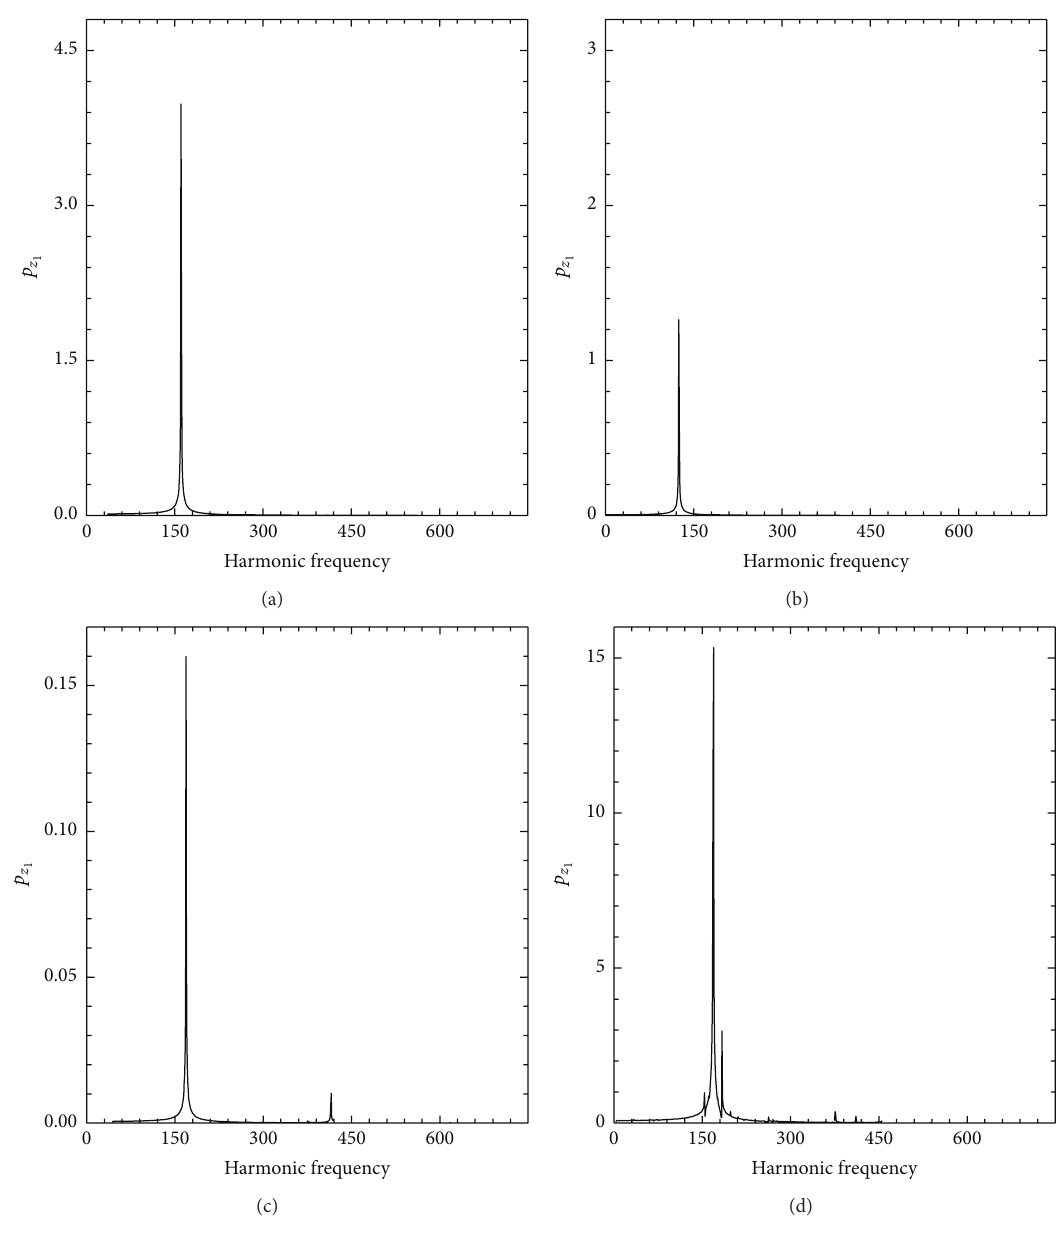
Figure 12: The frequency spectrum for (a) 𝜏 = 0 , (b) 𝜏 = 1.1 , (c) 𝜏 = 2 , and (d) 𝜏 = 5